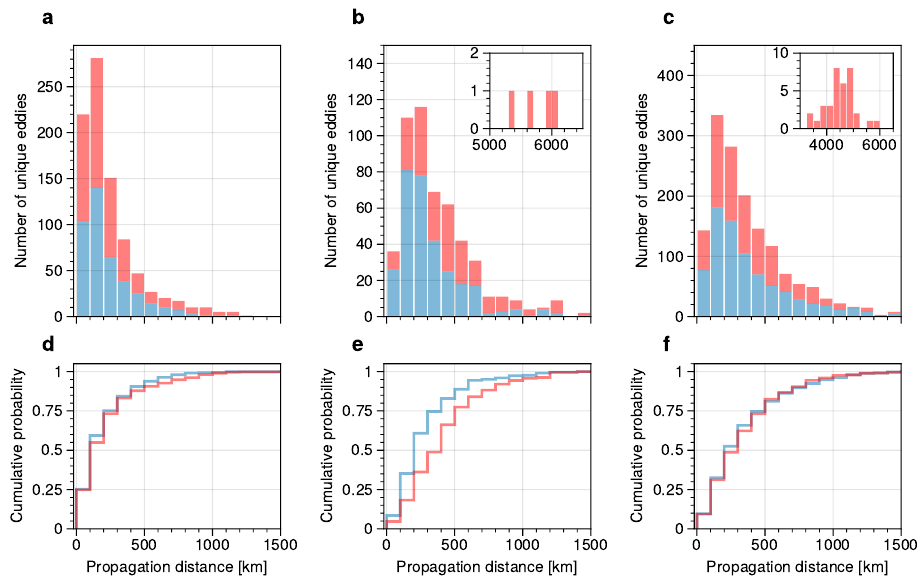
1500 Propagation distance Figure 8. Statistics of total propagation distance of unique compact eddies that were at some point in their lifespan observed in the regional box that loosely defines the South Brazil Bight. The upper panels ( a – c ) are histograms of propagation distance, with blue bars representing cyclones and red bars anticyclones. These are stacked histograms, so the number of anticyclones in each bins is the difference between its top and base. The lower panels ( d – f ) are cumulative histograms associated with ( a – c ). Left panels ( a , d ) are histograms for local eddies, middle panels ( b , e ) for remote eddies that eventually propagated into the Brazil Current region, west of the black dashed line in Figure 7, and right panels ( c , f ) are remote eddies that at some point in their lifespan were observed in the regional box but never moved into the Brazil Current region. The insets in ( b , c ) show a few remote anticyclones that were generated near the Agulhas Retroflection region and tracked across the South